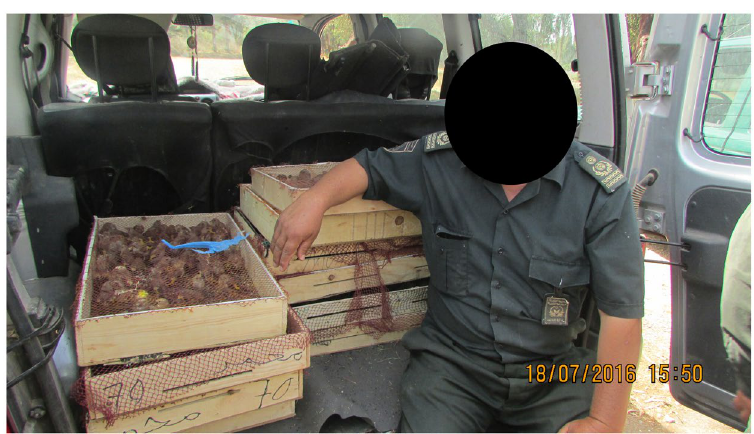
Figure 5. Apprehension of a thousand European goldfinches ( Carduelis carduelis ) by conservation authorities for illegal trading in Northwest Algeria near the Moroccan border (Oran,